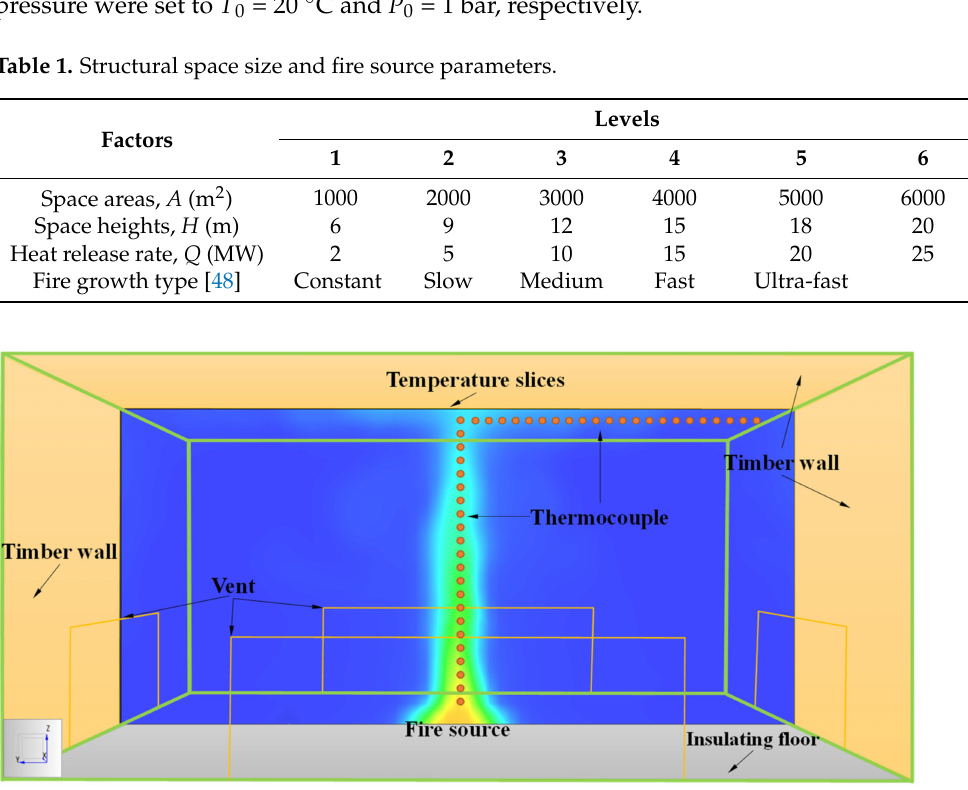
Figure 8. FDS simulation view of the